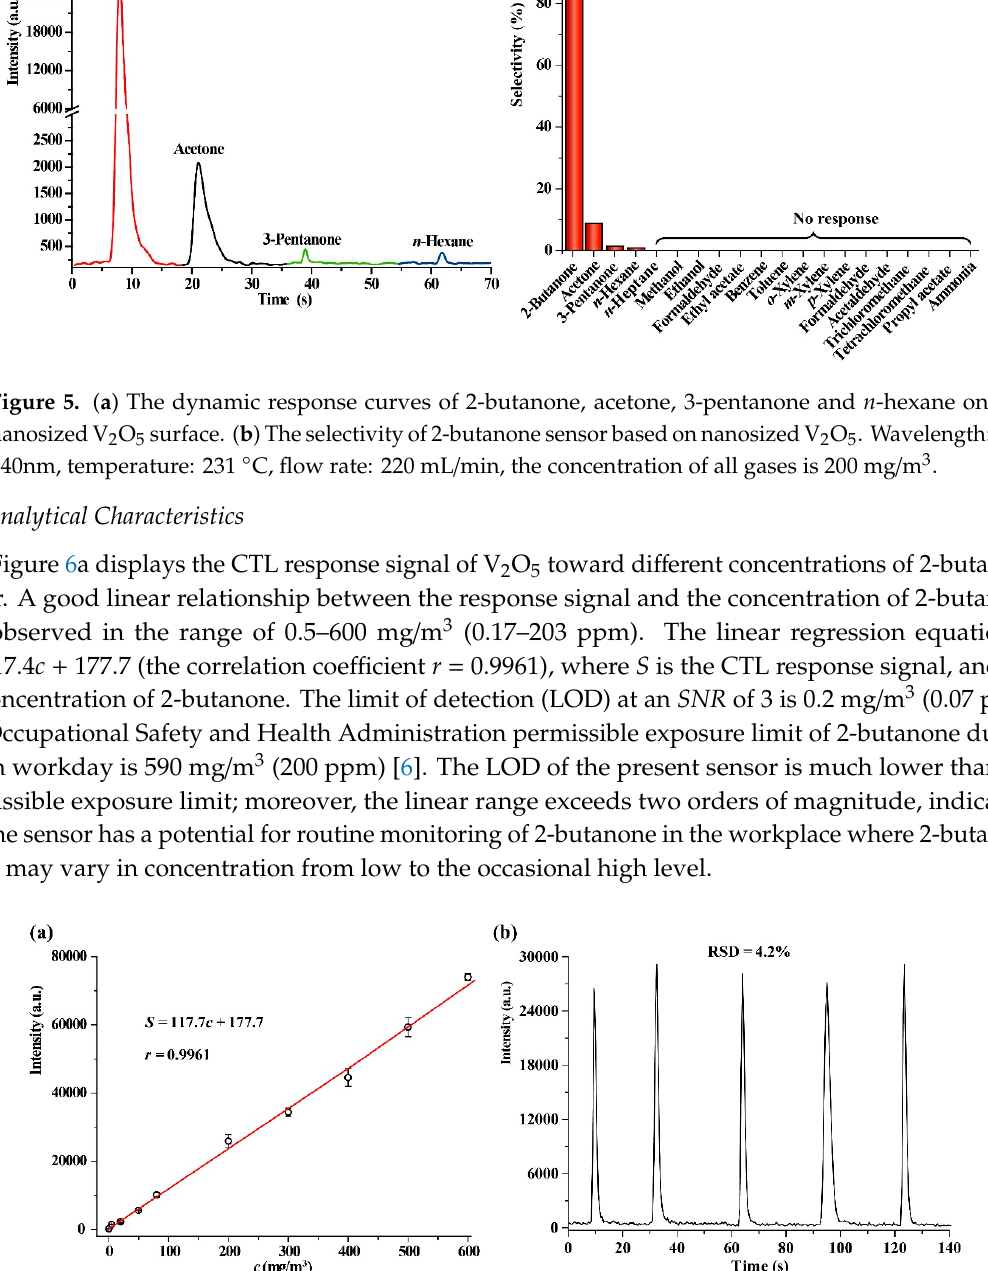
Figure 6. ( a ) Linear relationship between the CTL response signal and the concentration of 2-butanone. ( b ) Results of six replicate determinations of 2-butanone. Wavelength: 440nm, temperature: 231 ◦ C, flow rate: 220 mL /